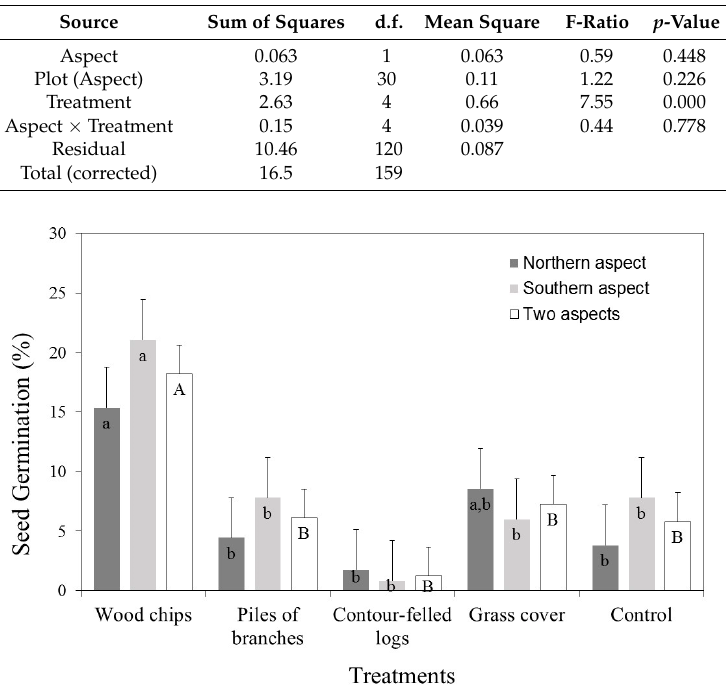
Figure 3. Mean values (±SE) of seed germination (untransformed units; %) depending on seeding method (treatment) and aspect for the study site. The bar chart shows the values for the two topographic aspects (pooled data) and within aspects (northern or southern aspects). For the two aspects, the means with the same capital letter were not significantly different, and the means within an aspect with the same lowercase letter were not significantly different (at the 0.05 level in all cases, according to the least significant difference (LSD) test). Sample data = 160 sub-plots (50 × 50 cm); 80 within each